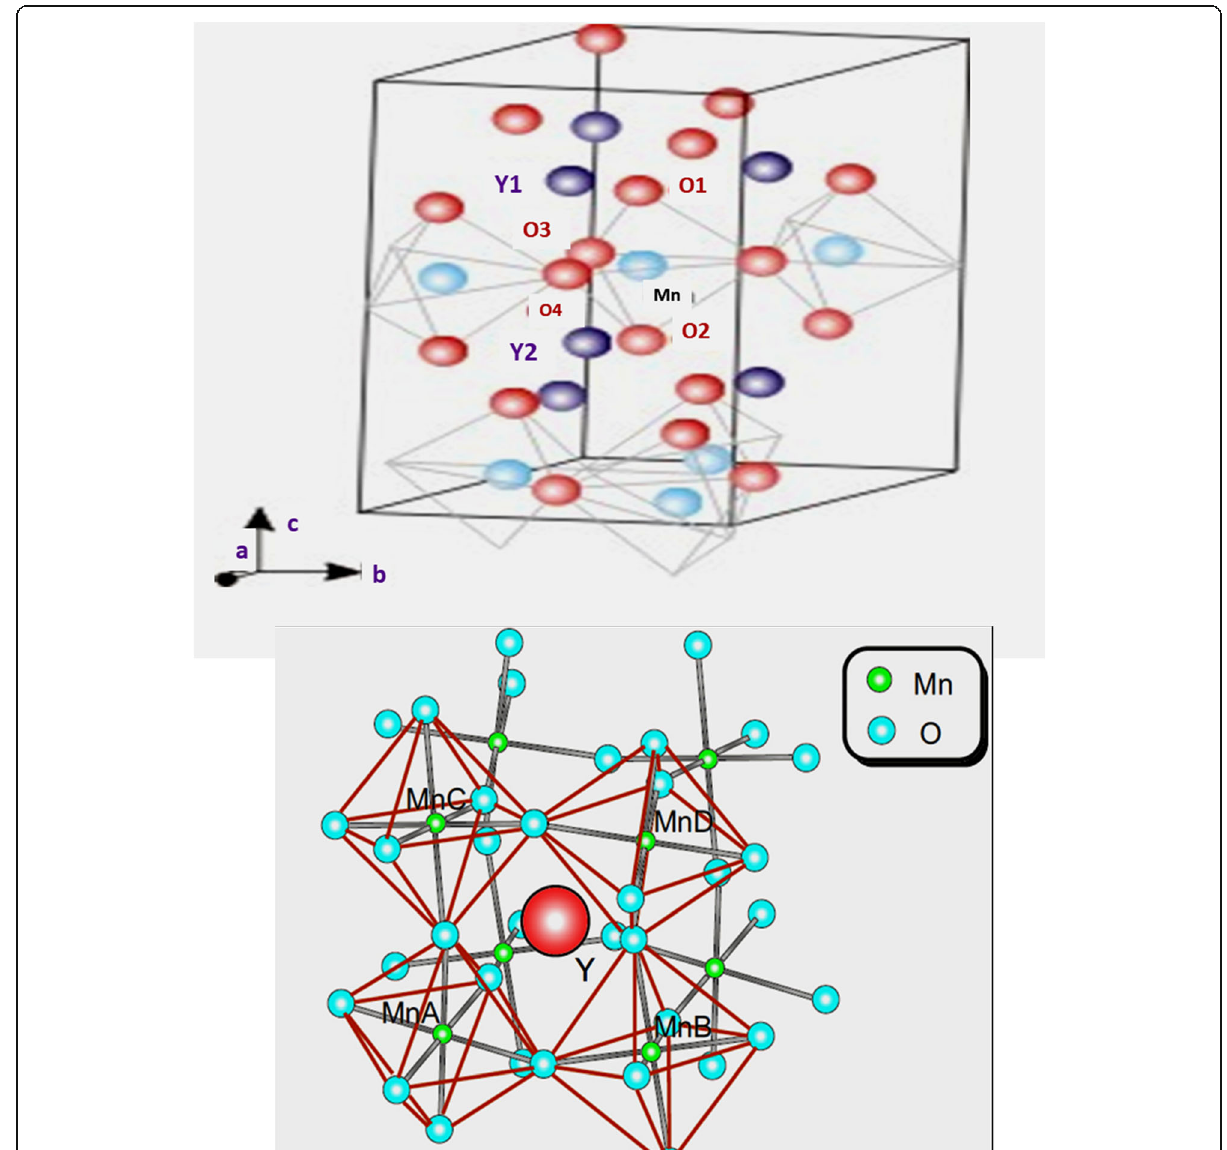
Fig. 5 Crystal structure of YMnO 3 featuring layers of MnO 5 polyhedra and Y atom in between the layers. Adapted from Wadati et al.